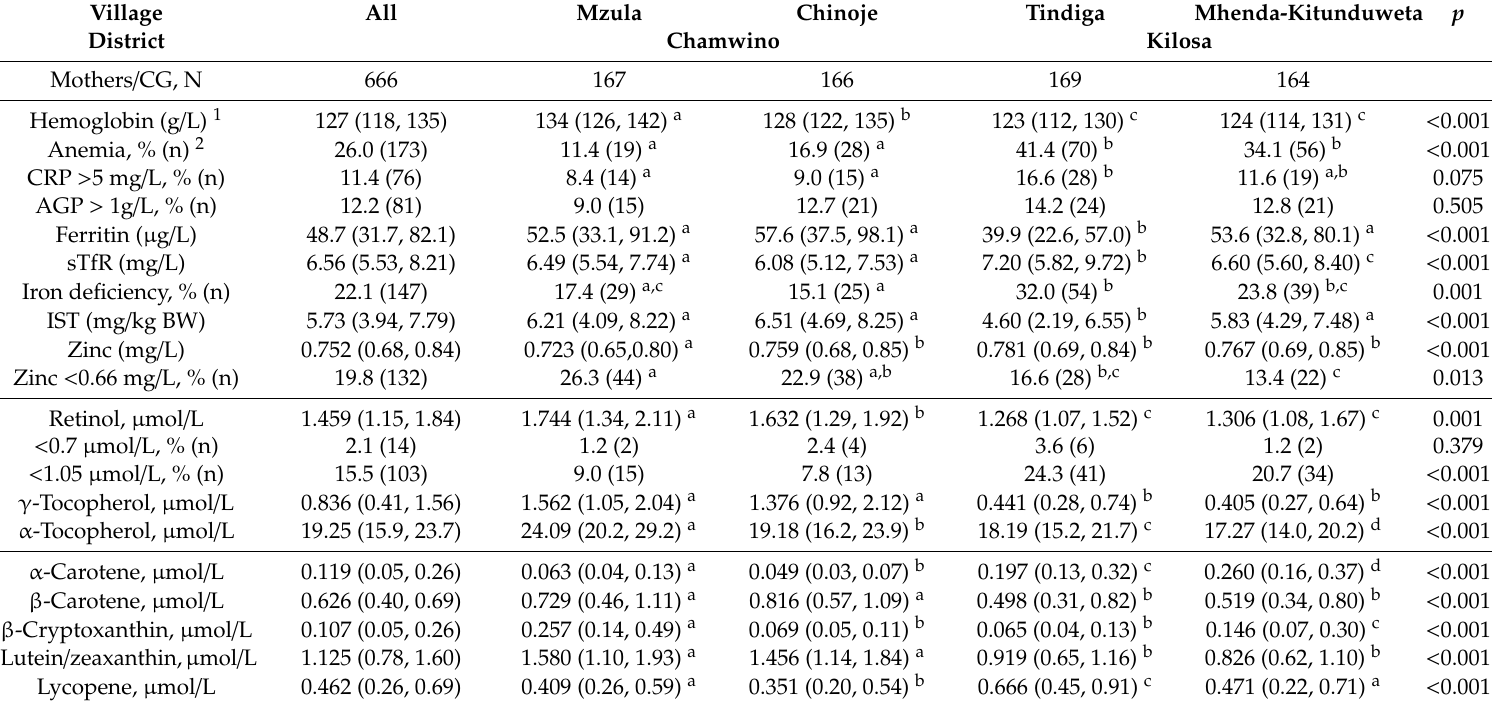
Table 2. Hemoglobin, infection- (CRP, AGP) and iron status markers (ferritin, sTfR), and serum micronutrients in mothers / CG *.